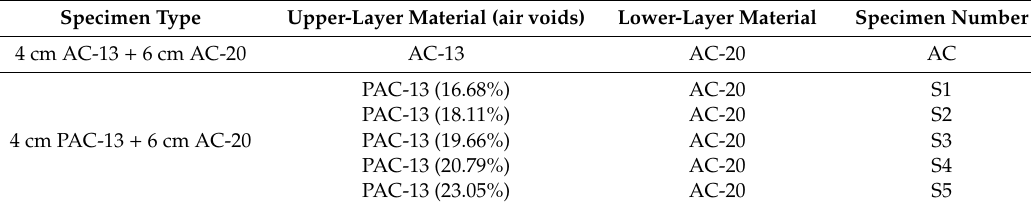
Table 2. Results of the design of structural